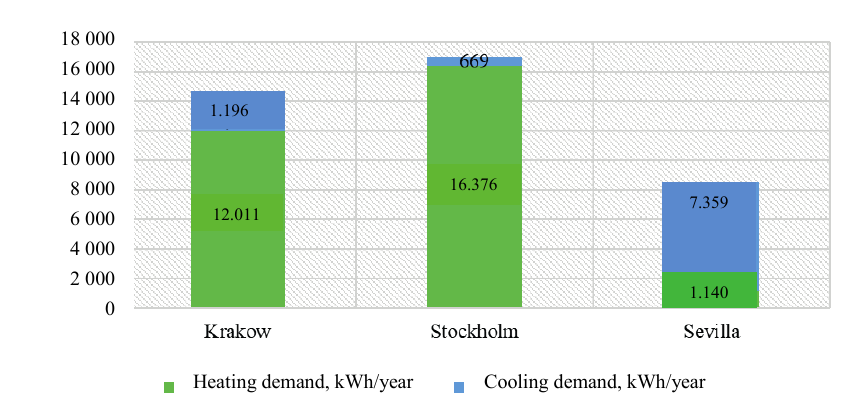
Fig. 5. Results of the total heating and cooling demand